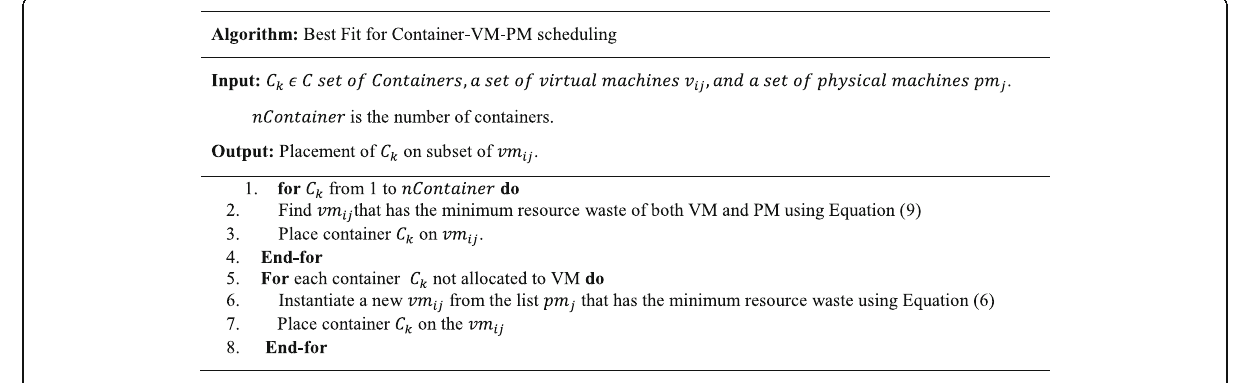
Fig. 5 The Best Fit algorithm for container-VM-PM